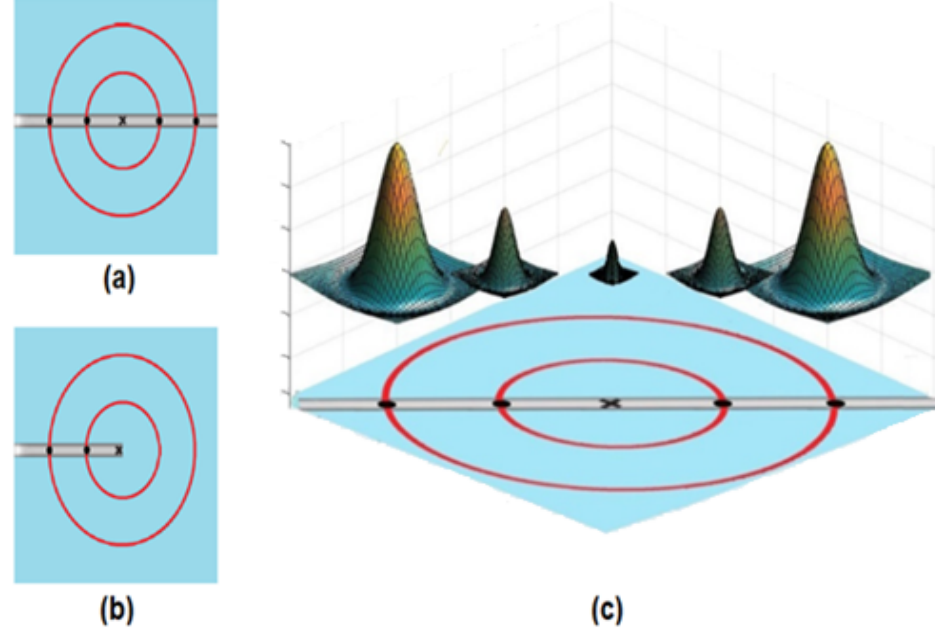
Figure 5. The types of detected patterns: ( a ) line-like pattern; ( b ) half line-like pattern; and ( c ) combinations of the created DoG filter to produce the five blobs for the SRF filters.